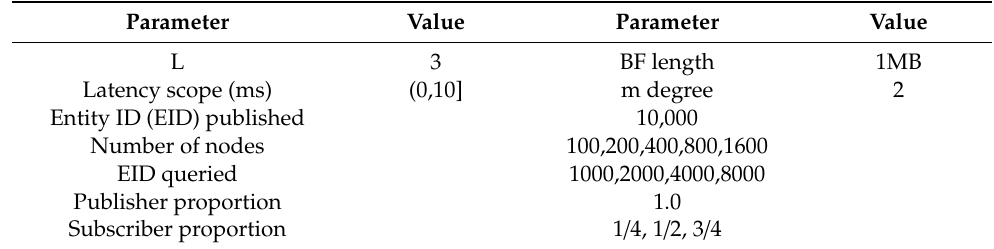
Table 3. Evaluation